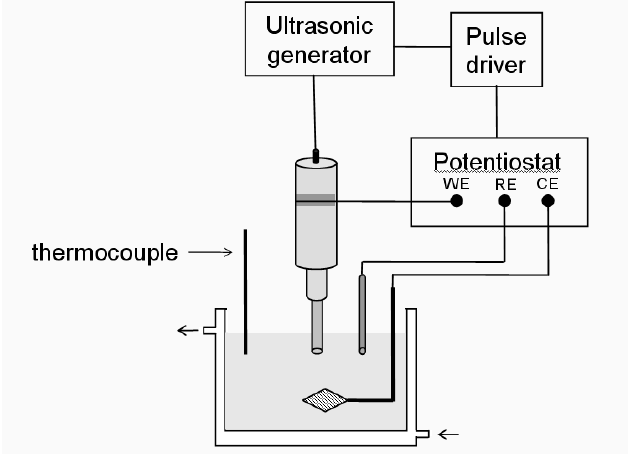
Figure 1. Sonoelectrochemistry set-up used in the production of nanopowders (WE working, RE reference and CE auxiliary